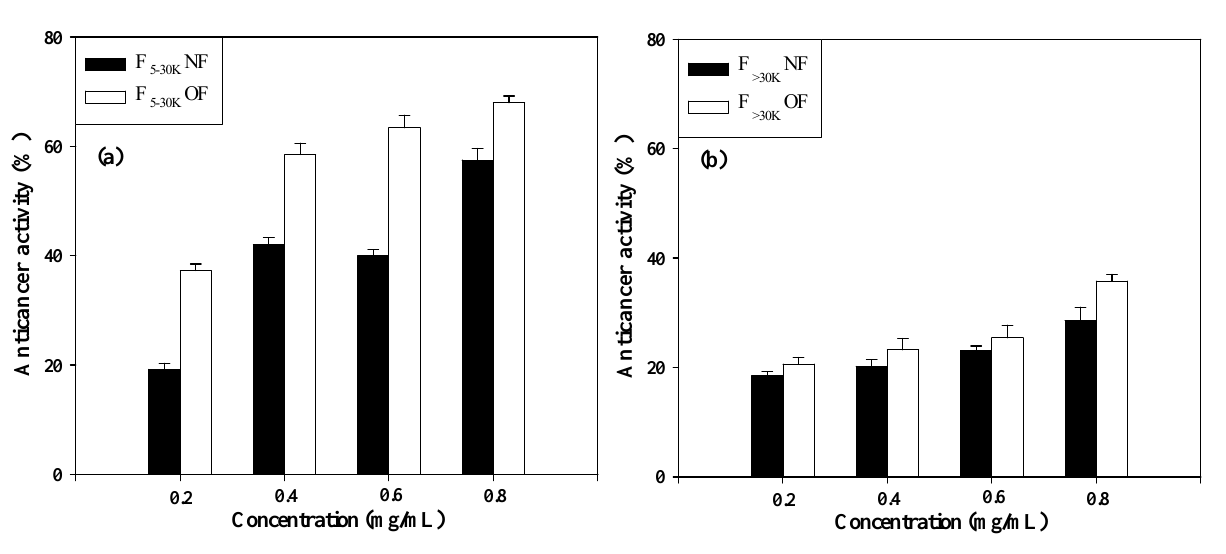
Figure 2. Anticancer activity of native and oversulfated fucoidans against the human fraction of native and oversulfated fucoidans and stomach cancer cell line AGS. (a) F 5-30K (b) F fraction of native and oversulfated >30K